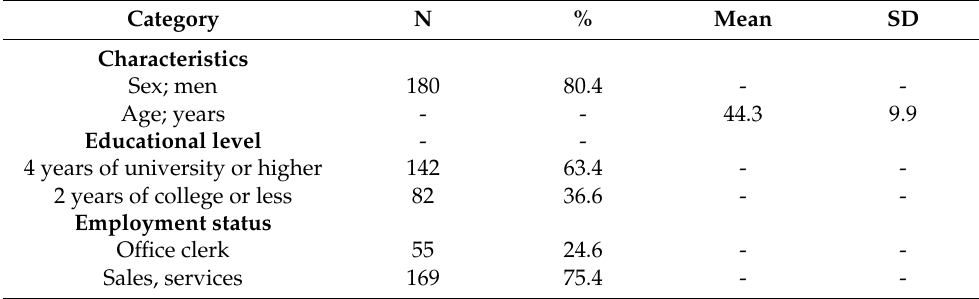
Table 1. Characteristics of the participants ( N =